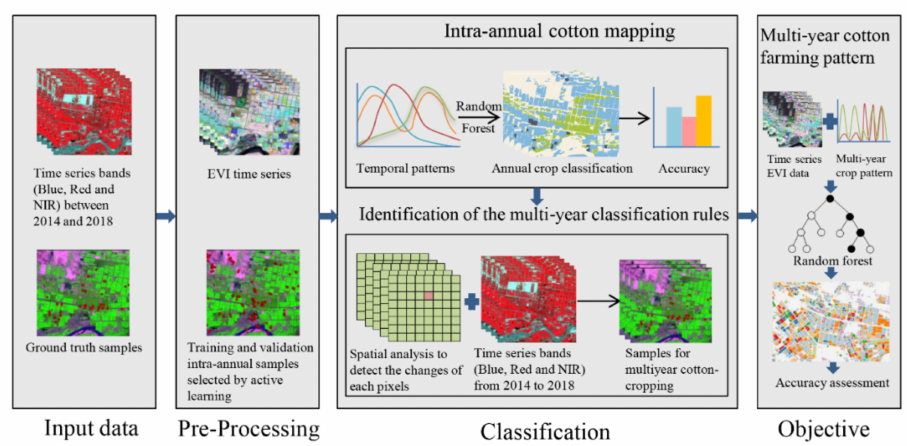
Figure 4. Flow chart of this study.